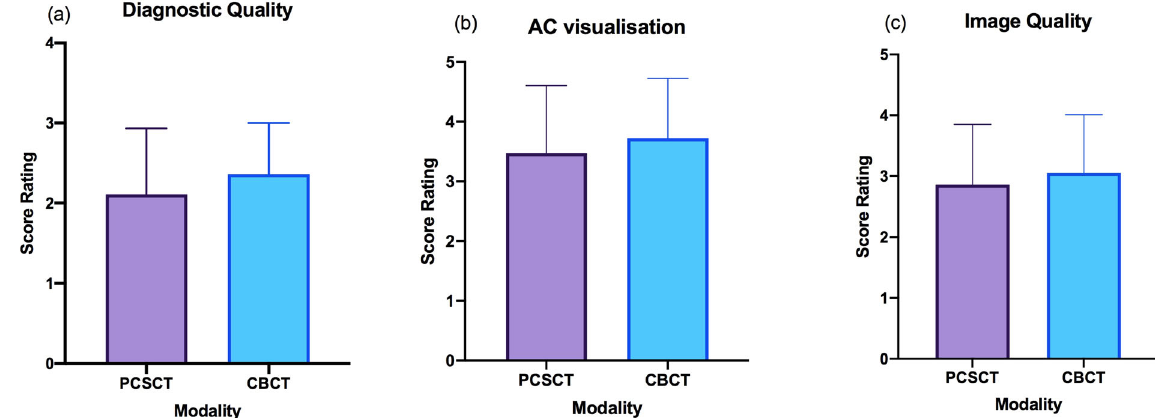
Fig. 3 Qualitative assessment between PCSCT and CBCT. The average results from the two scorers for the six teeth for ( a ) diagnostic quality, ( b ) AC visualisation and ( c ) image quality.